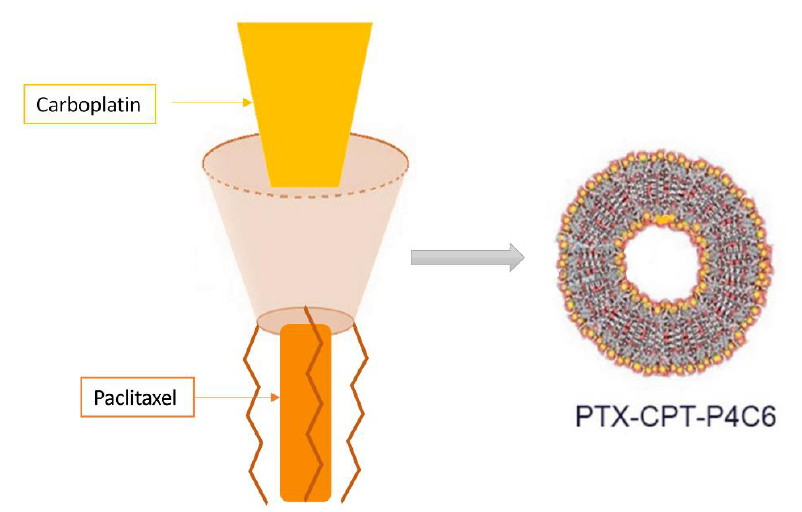
Figure 3. Schematic representation of the calyxarene structure capable of hosting both CPT and